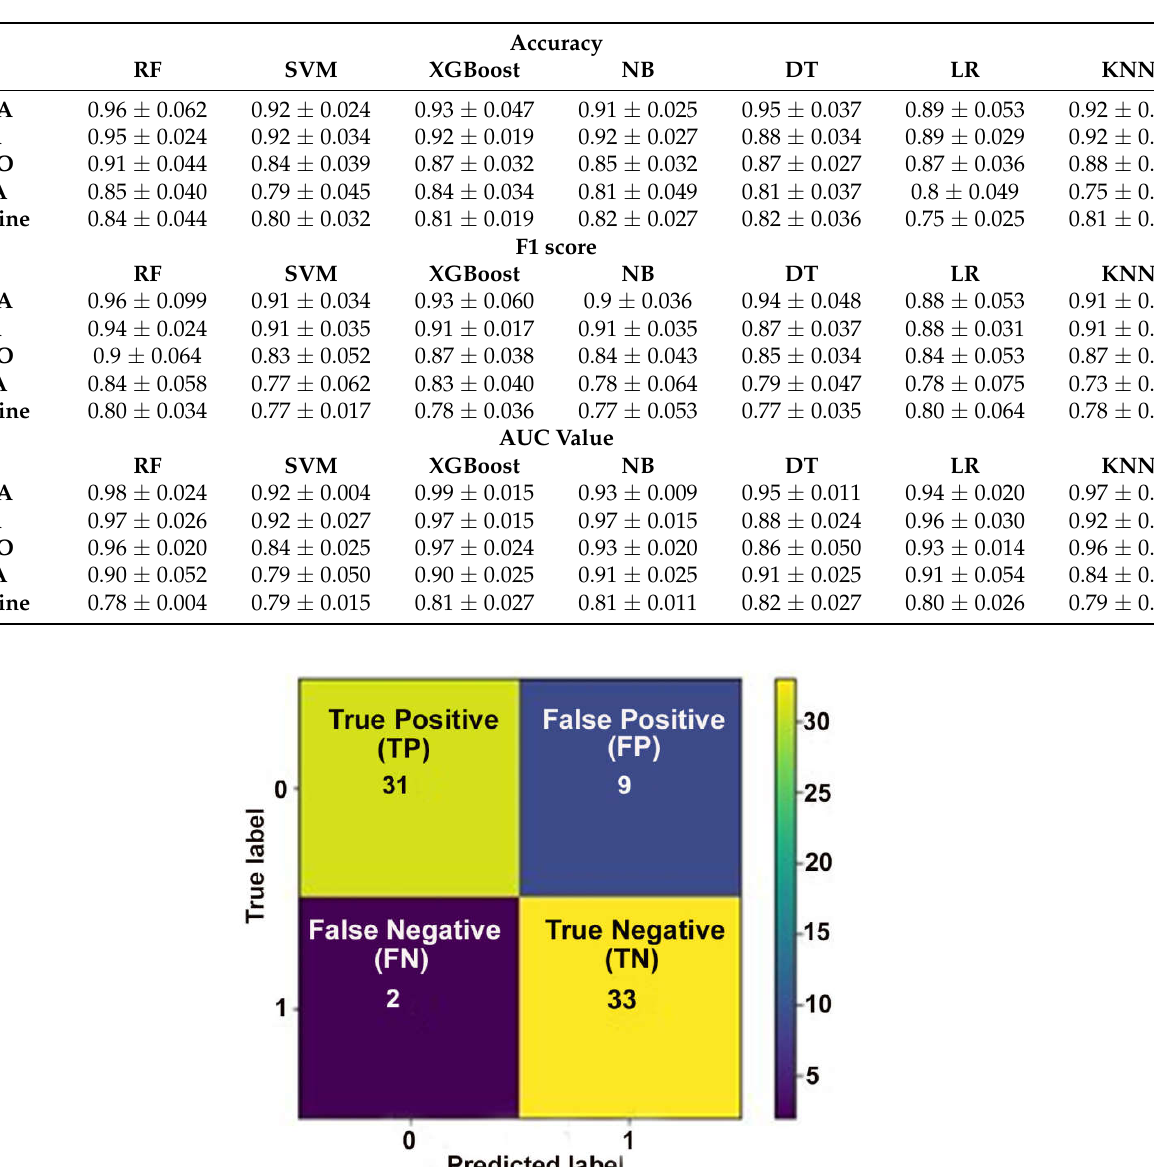
Table 5. Comparative performance evaluation of the seven predictive models built in terms of (a) accuracy, (b) F1 score, and (c) AUC value using the four optimal feature subset obtained by the WOA, GA, GWO, and SCA meta-heuristic algorithms.